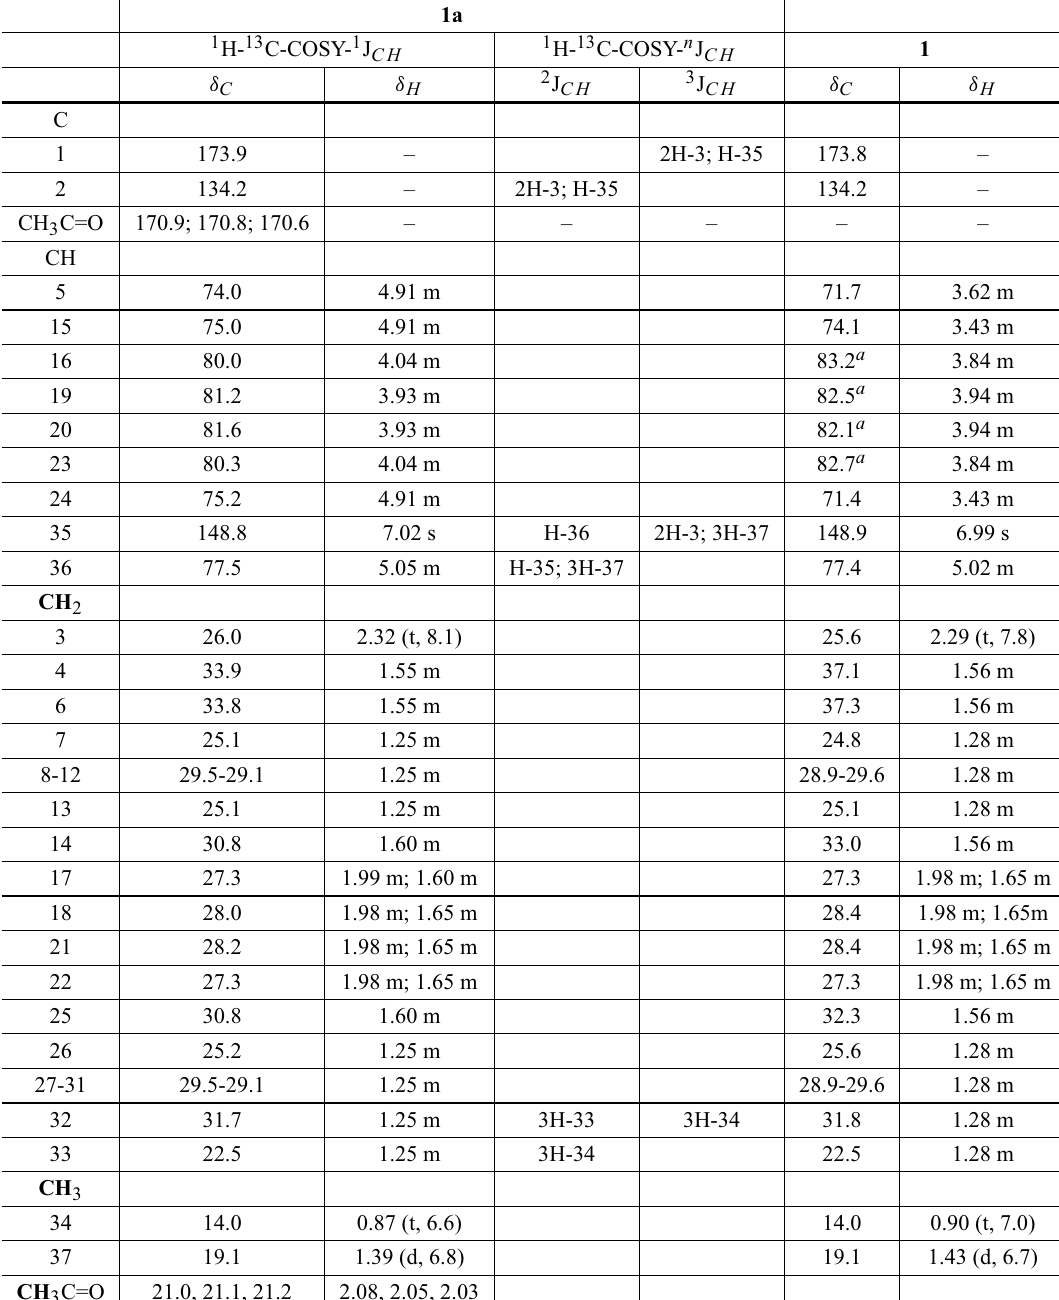
TABLE I 1 H (500 MHz) and 13 C (100 MHz) NMR spectral data for 1 and 1a, including heteronuclear 2D shift-correlated obtained by 1 H and 13 C-COSY- n J CH (n=1, HMQC, n=2 and 3, HMBC)